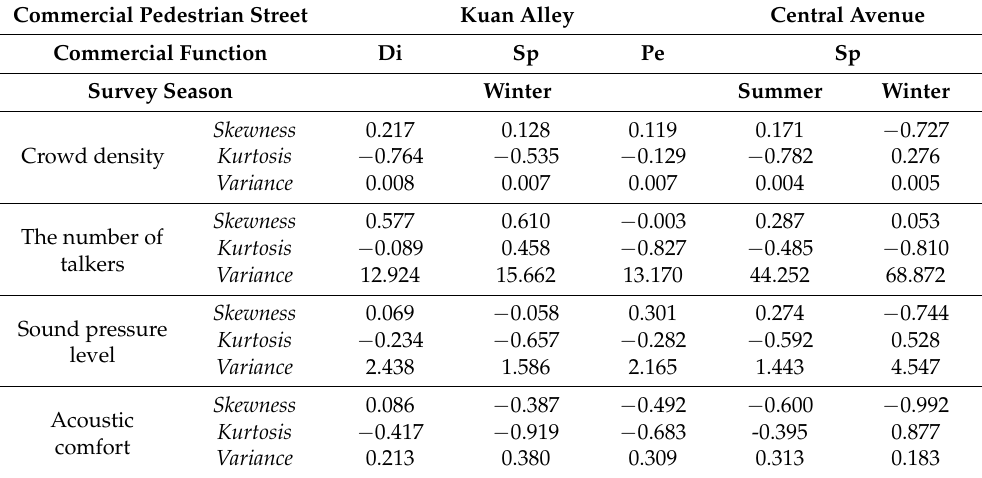
Table 3. The normality of samples.